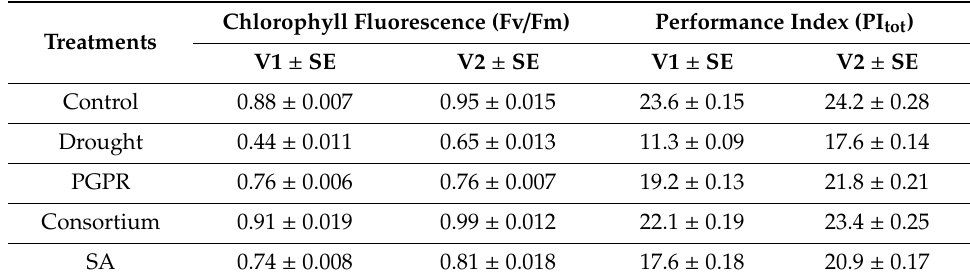
Table 2. Chlorophyll fluorescence ( Fv / Fm ratio) and performance index (PItot) of two maize varieties under di ff erent